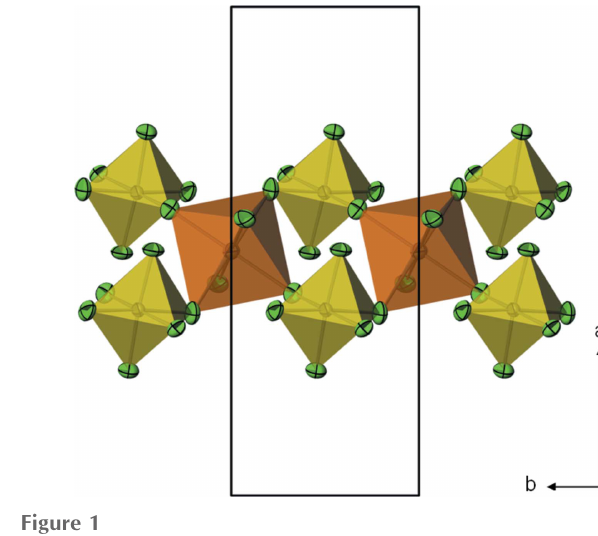
Figure 1 [AlF 6 ] octahedra (yellow, with F atoms green) and [FeF 6 ] octahedra (orange) are linked into crosslinked double chains parallel to [010]. Displacement ellipsoids are drawn at the 74% probability